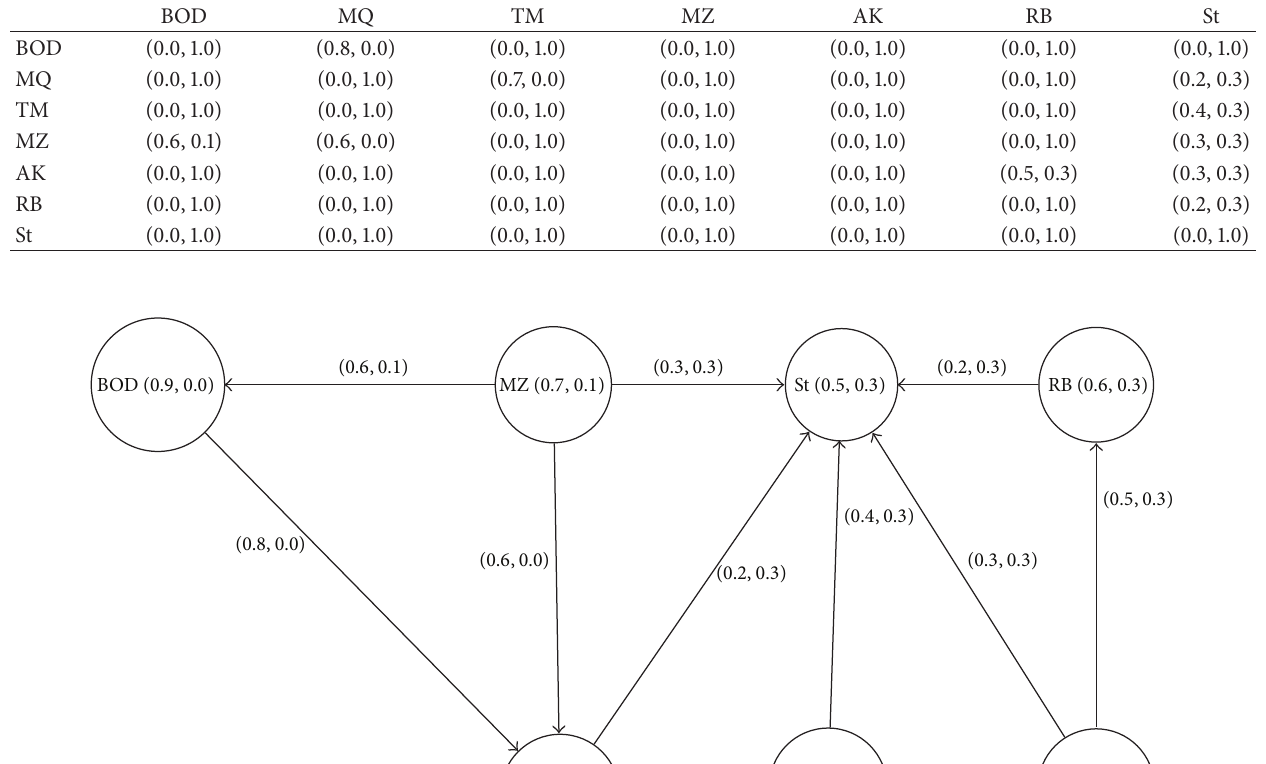
Table 3: Adjacency matrix corresponding to Figure 2.